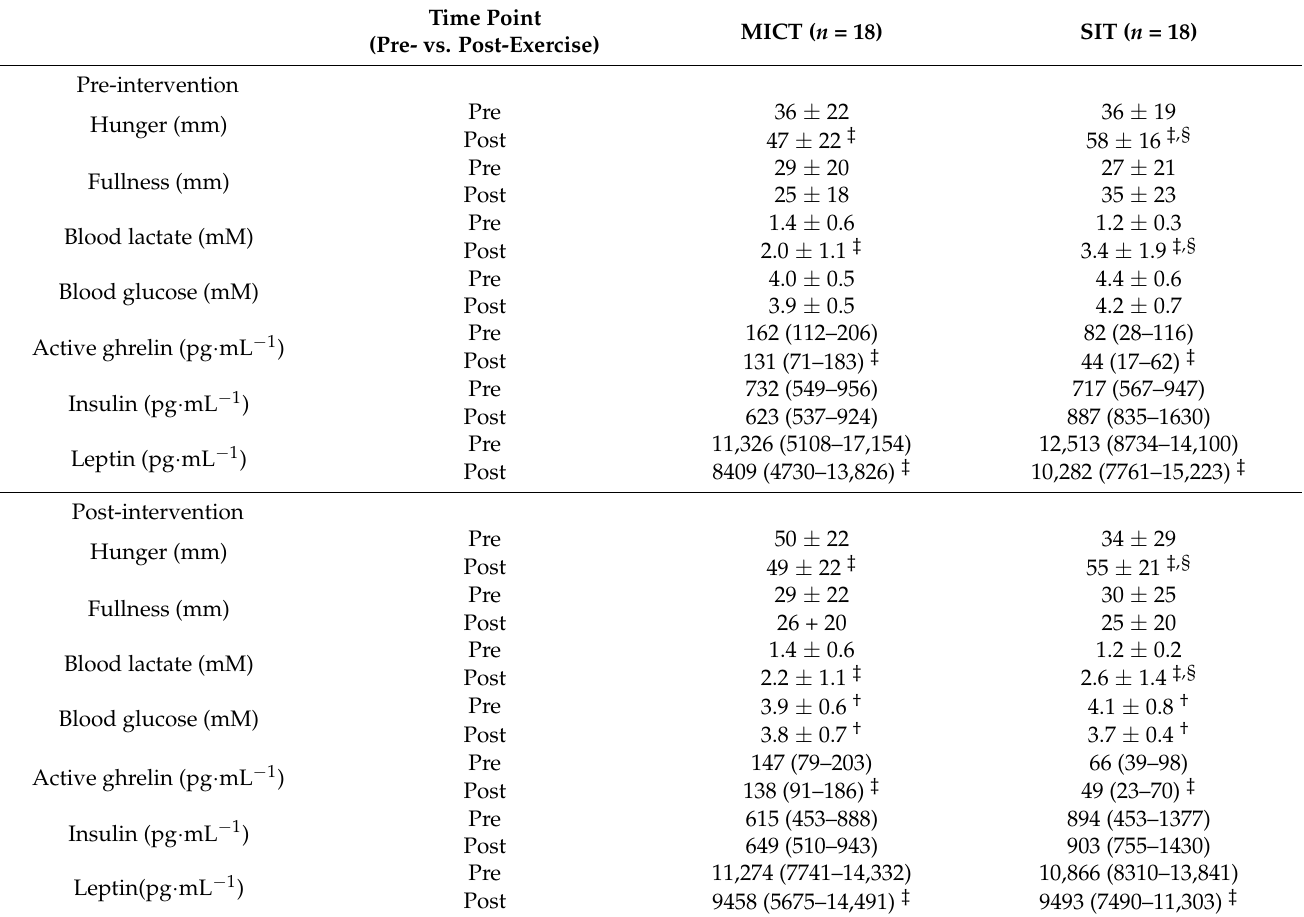
Table 4. Capillary concentrations of appetite-related blood variables in the fasting state (pre) and in response to 30 min of SIT and MICT exercise (post) performed before and after 12 weeks of SIT or MICT [(mean ± SD) or median